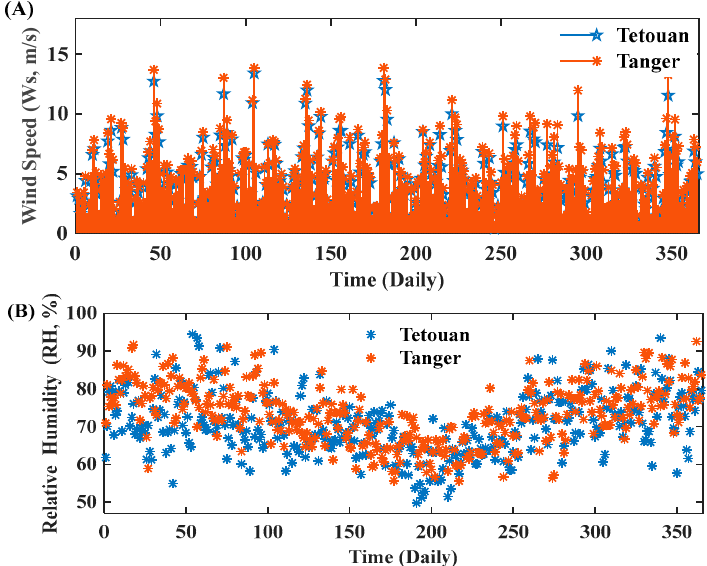
Figure 3. ( A , B ) Daily global solar radiation distribution through a year of two sites. In Figure 4A,B shows the daily wind speed (Ws) and relative humidity (Rh) over the year for the Tetouan and Tangier sites. The range value of wind speed varies by about 13.02 m/s and 13.3 m/s, respectively, for the Tetouan and Tangier sites. In the cold period, the highest relative humidity for the Tetouan and Tangier sites was 94.5% and 92.58%. In a warm period, the lowest relative humidity was 49.75% and 55.54%, respectively, for Tetouan and Tangier sites.